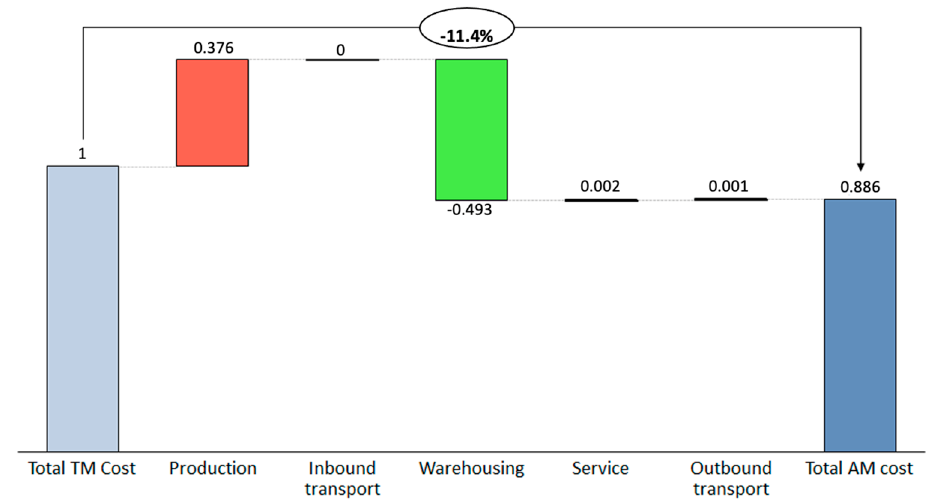
Figure 9. Difference in cost between AM and TM for P1, shown in normalized values.